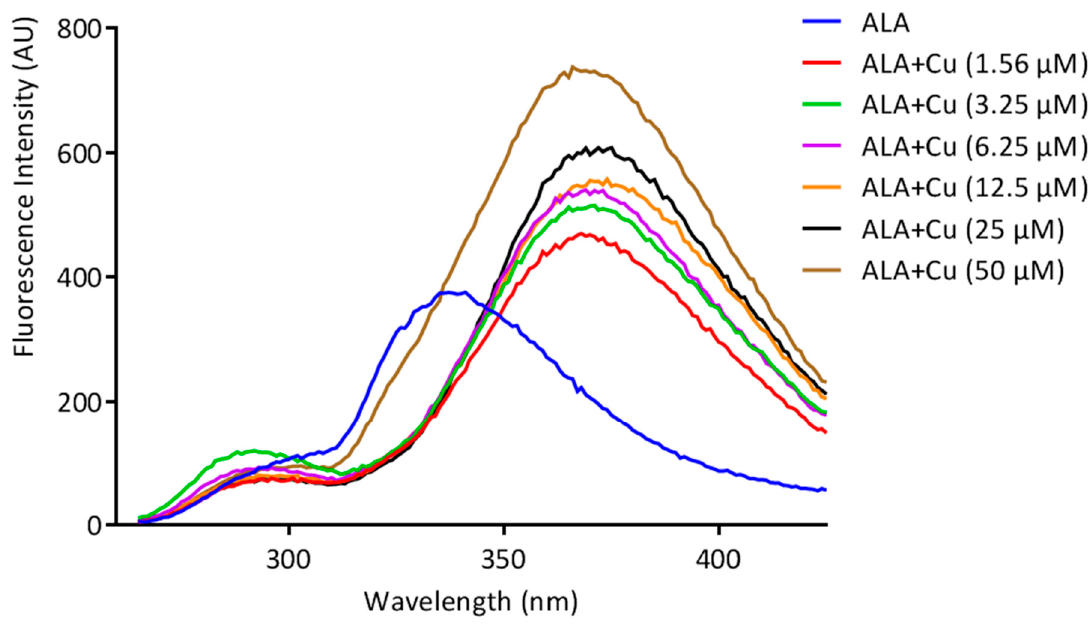
Figure 2. Fluorescence titration of ALA (100 µ M) with increasing concentrations of Cu (0–50 µ M). A bathochromic or red shift was observed from 337 nm to 367 nm, along with the hyperchromic shift.